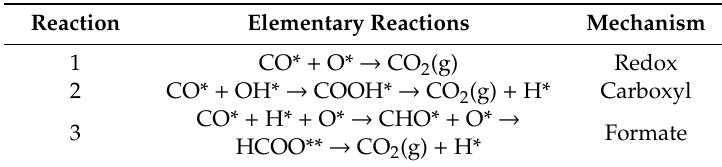
Table 10. Reaction mechanisms.